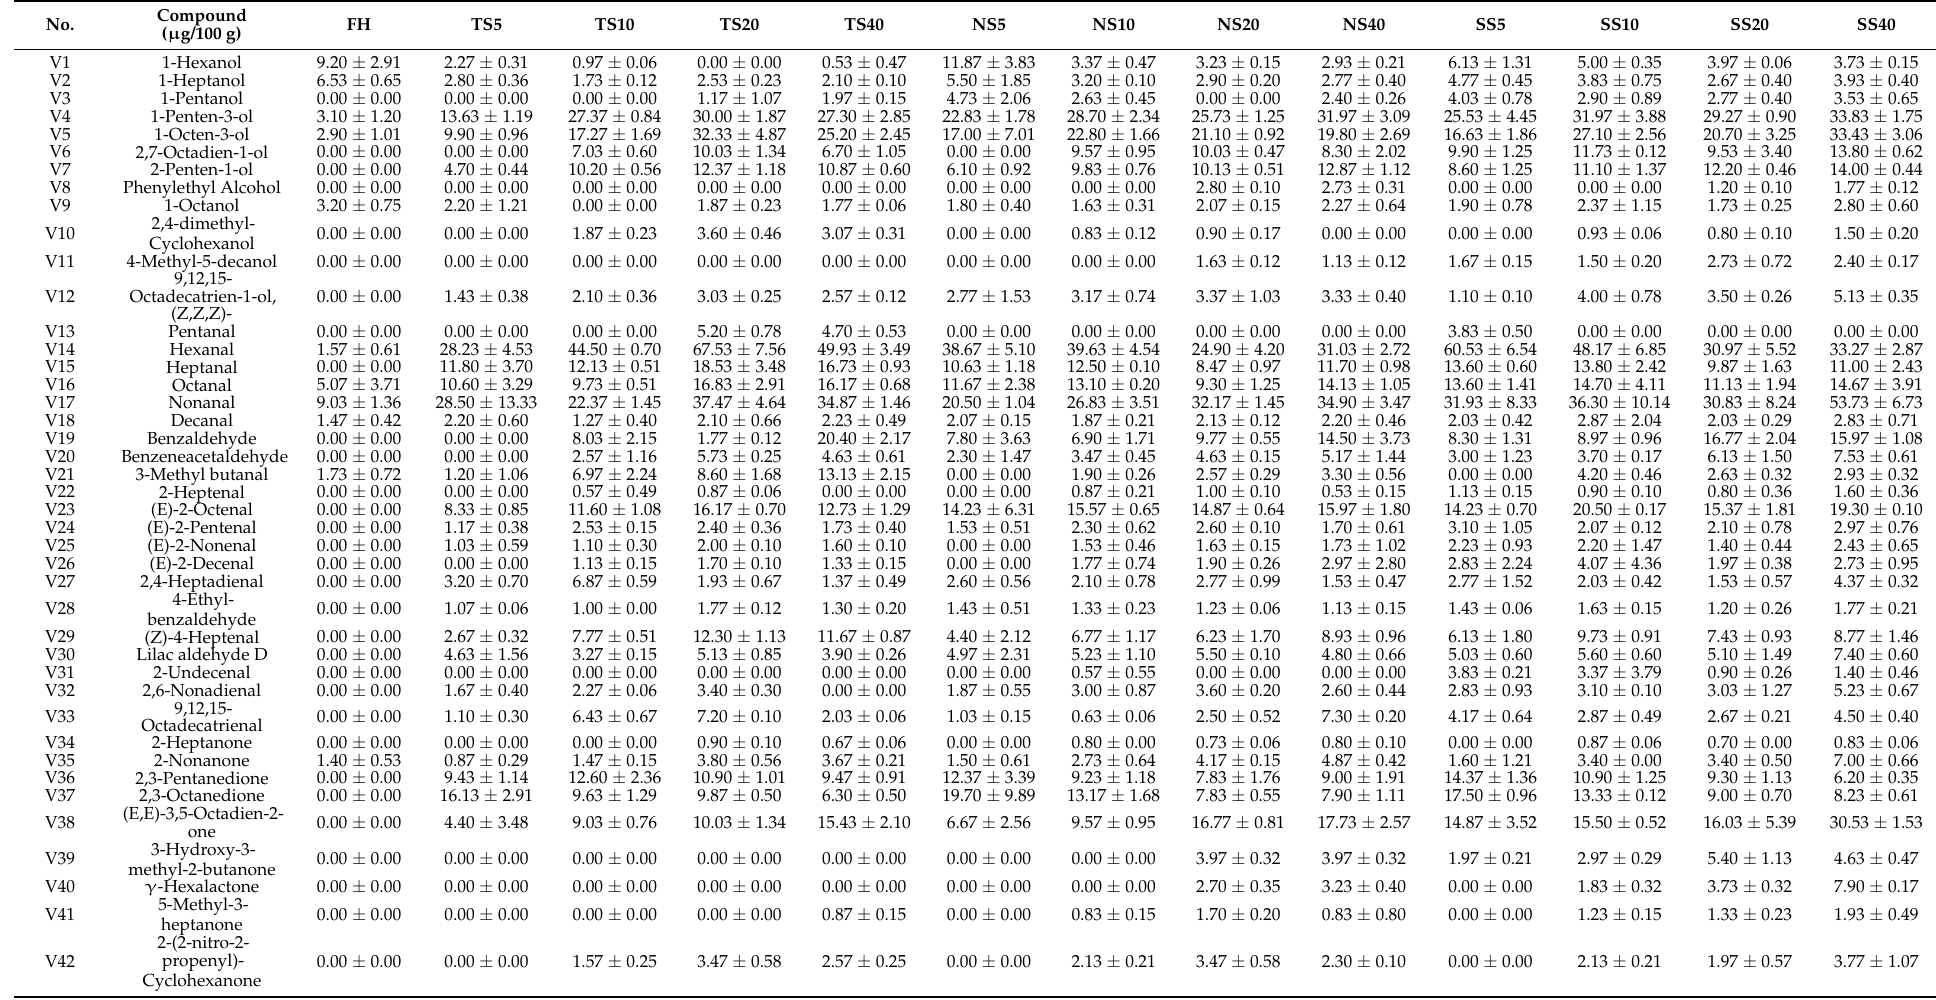
Table A2. The volatile component contents in the salted herring under different processing